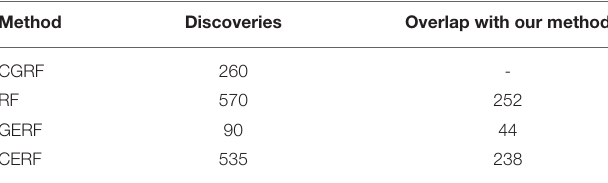
TABLE 3 | The important abnormal hippocampal voxels identified by the traditional random forest.